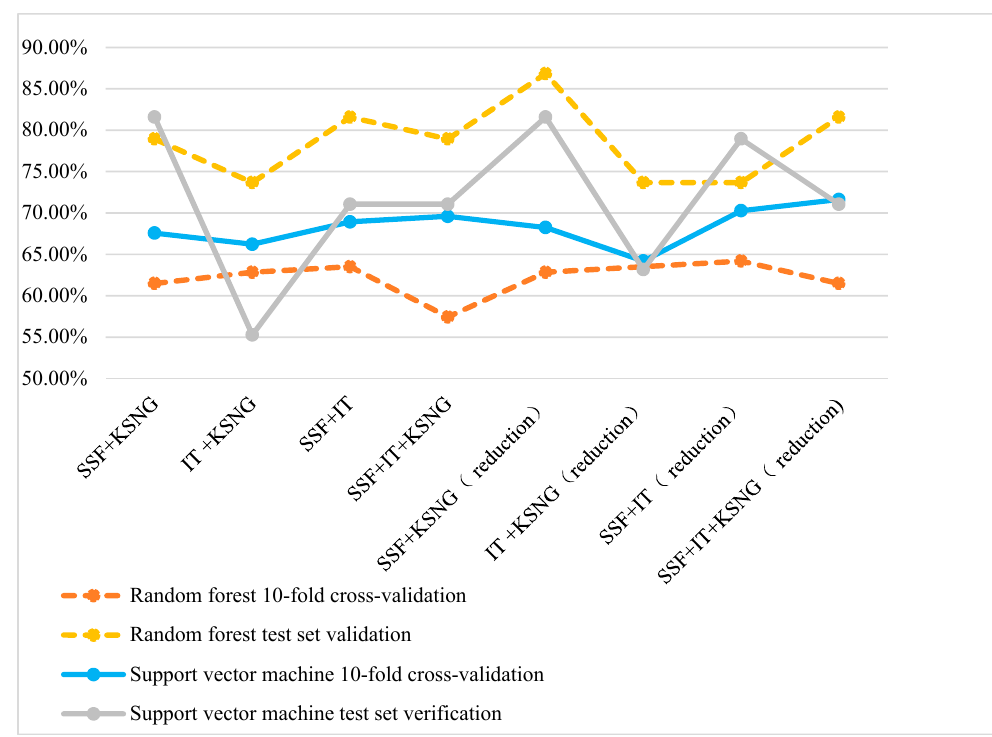
Figure 2. Comparison of the classification accuracy of single feature representation methods.